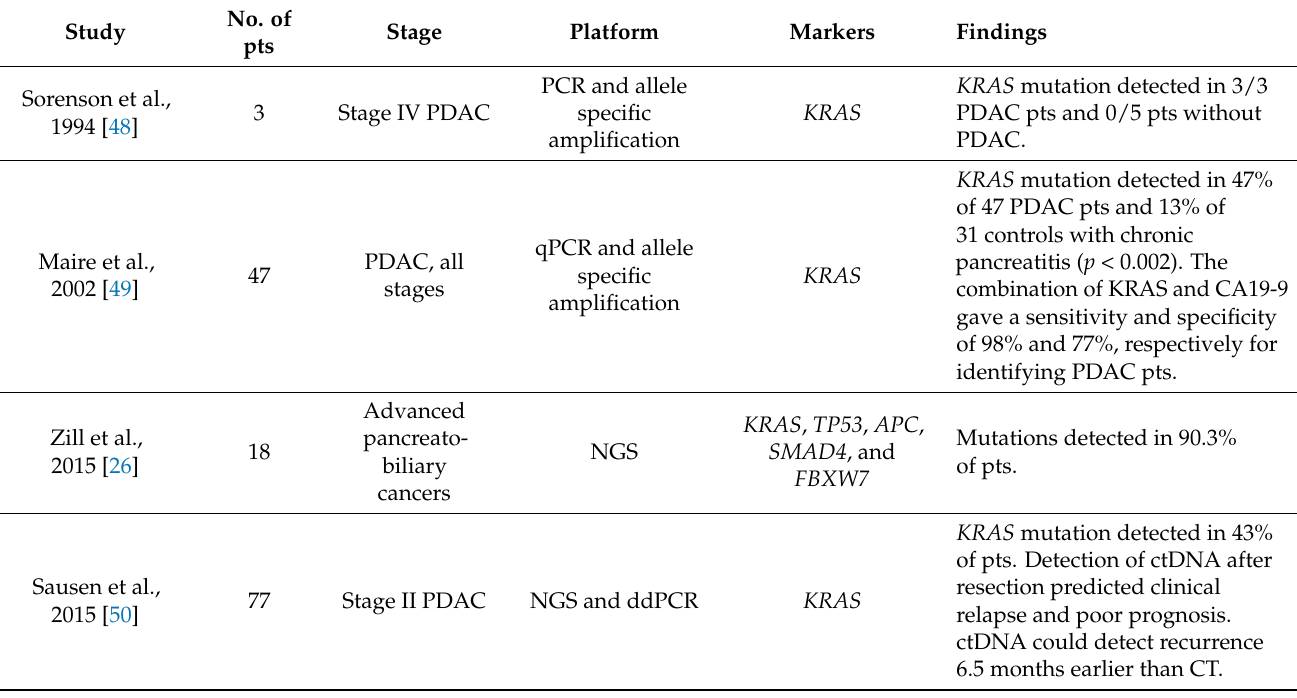
Table 1. Studies of ctDNA-based liquid biopsy in pancreatic ductal